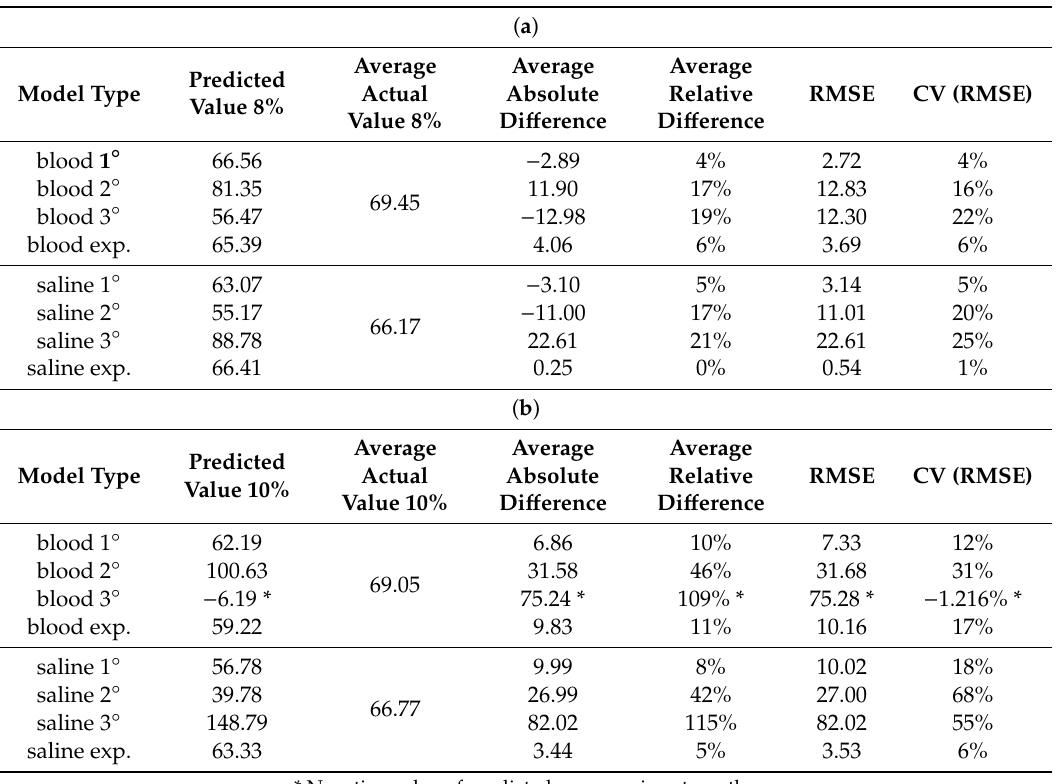
Table 6. Prediction accuracy of selected models for ( a ) 8% and ( b ) 10% admixture from the 0–8% model. ( a